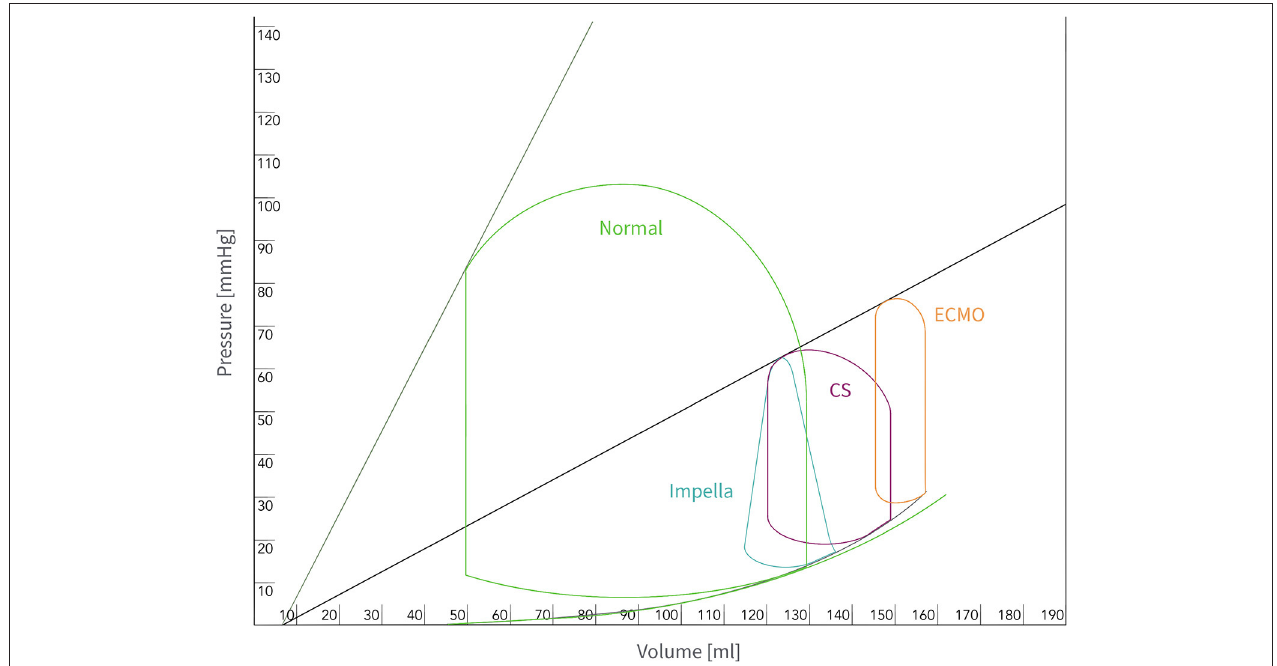
FIGURE 1 | Pressure-volume relationship: Normal conditions (CO 5l; green), CS (CO 3l, PAWP 27 mmHg; purple), CS on VA-ECMO support (3l flow, orange); CS on Impella TM CP support and “P” Level 9 (4l flow; turquoise). The pressure-volume area represents an estimate of mechanical work performed by the ventricle. The pressure-volume area is only reduced with the Impella TM , thus decreasing LV work. CO, Cardiac output; CS, Cardiogenic shock; LV, Left ventricular; PAWP, Pulmonary artery wedge pressure; VA-ECMO, veno-arterial extracorporeal membrane oxygenation